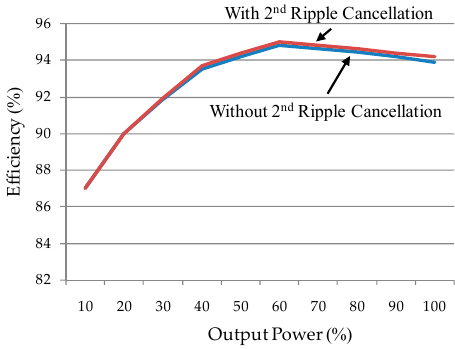
Figure 14. Power conversion efficiency of MI without and with proposed 2nd ripple voltage cancelation control.